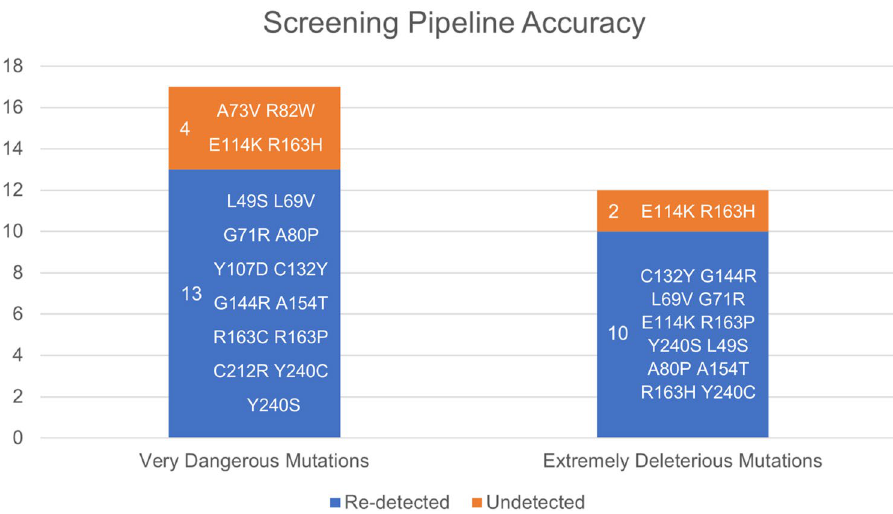
Figure 2. Accuracy of the in silico screening pipeline with respect to the pre-identified deleterious missense mutations of human